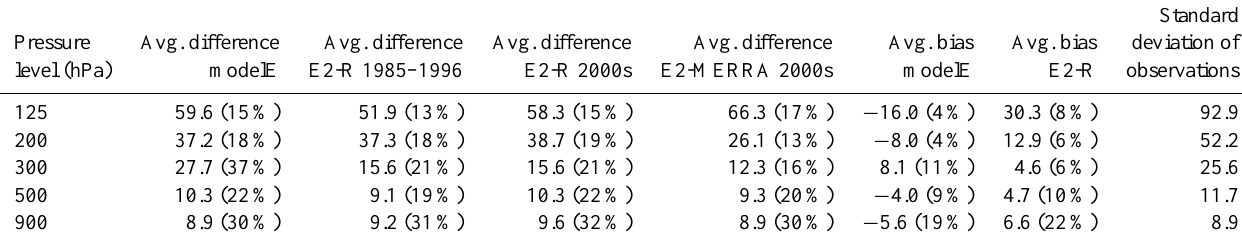
Fig. 1. Total ozone column (DU; left column) in the model simulations and in observations during 2000–2010 (TOMS from 2000–2004, OMI from 2004–2010), and model-observation differences (%; right column). Global mean column values are given in the upper right of each panel. Table 1. Ozone differences and biases (ppbv) between models and sondes.